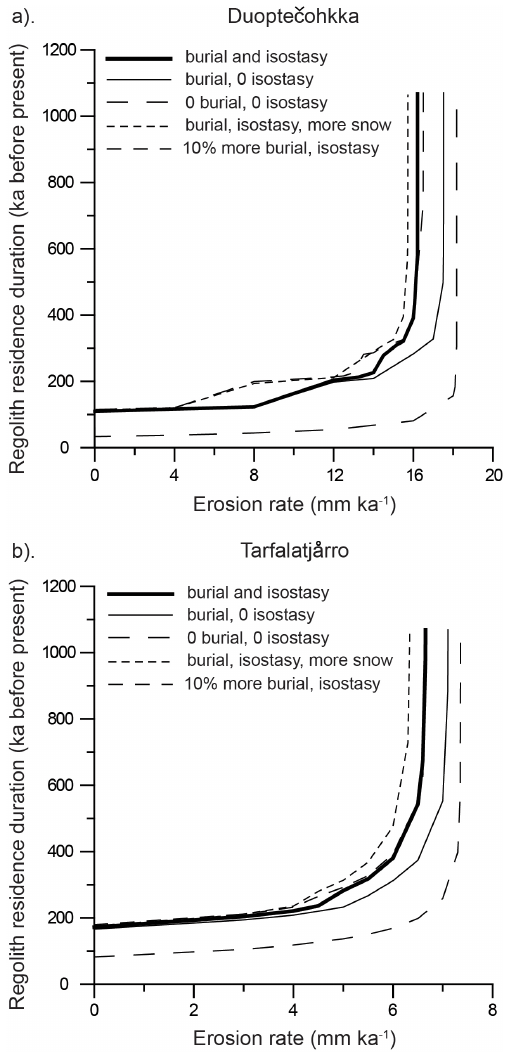
Figure 8. Regolith residence durations for (a) Duopteˇcohkka and (b) Tarfalatjårro plotted against surface erosion rates. These are modelled using 10 Be concentrations in regolith surface quartz clasts and incorporate periods of burial by ice sheets and changes in 10 Be production rates attributable to glacial isostasy. Seasonal burial of ground surfaces by 30 cm of snow for 7 months of the year is included. Five different scenarios were modelled: (i) ice sheet burial duration and glacial isostasy (marked “burial and isostasy” in the plots), which is our primary model output; (ii) isostasy is re- moved (“burial, 0 isostasy”); (iii) a simple surface exposure history, from which burial and glacial isostasy are excluded (“0 burial, 0 isostasy”); (iv) the first scenario is replicated, but snow depth and snow cover duration are increased to 50 cm and 10 months of the year, respectively (“burial, isostasy, more snow”); (v) each burial period is extended by 10% and exposure periods commensurately shortened (“10% more burial,